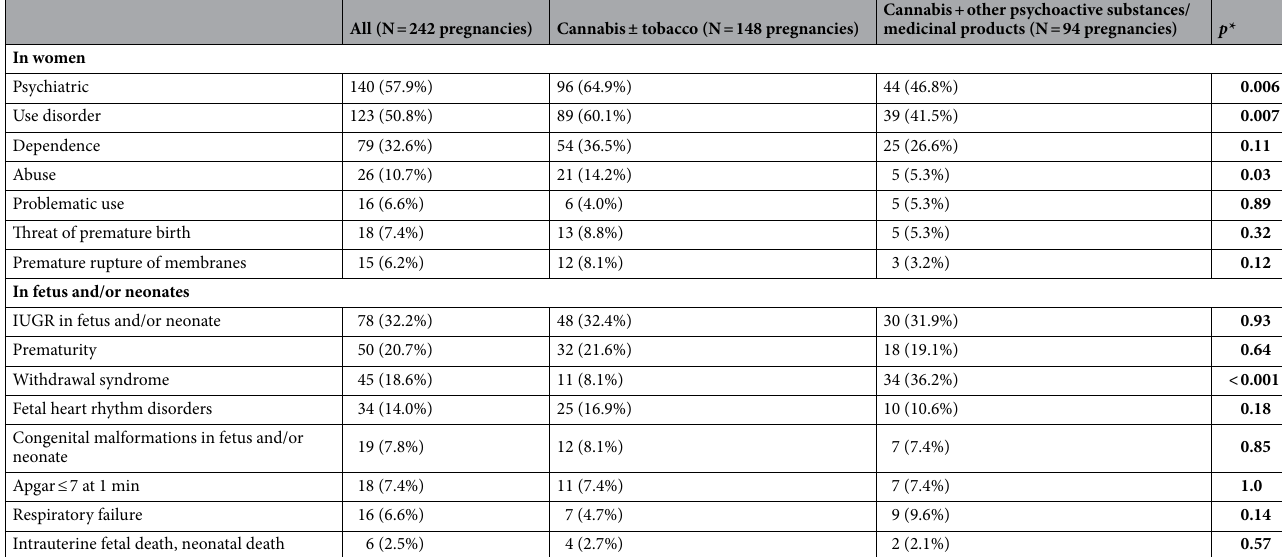
Table 3. Main AEs related to cannabis use during pregnancy in women and fetus and/or neonates. *p value derived from Chi-square test for comparison of proportion. Significant values are in